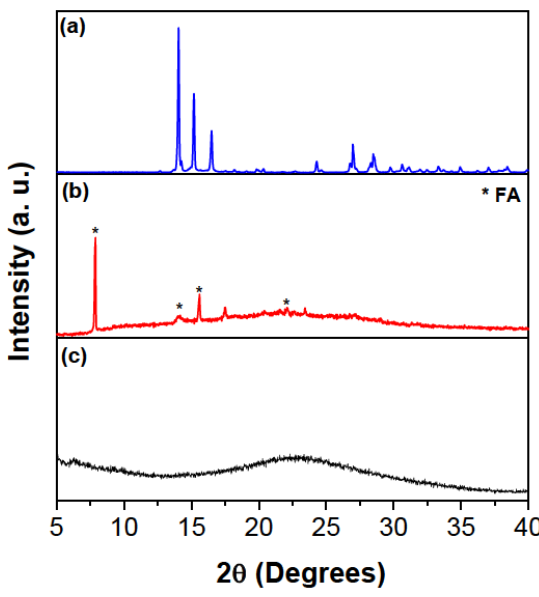
Figure 4: XRD partners of (a) Cis-Pt, (b) MNPSiO 2 -FA/Cis-Pt, and (C) MNPSiO 2 samples. *FA (folic